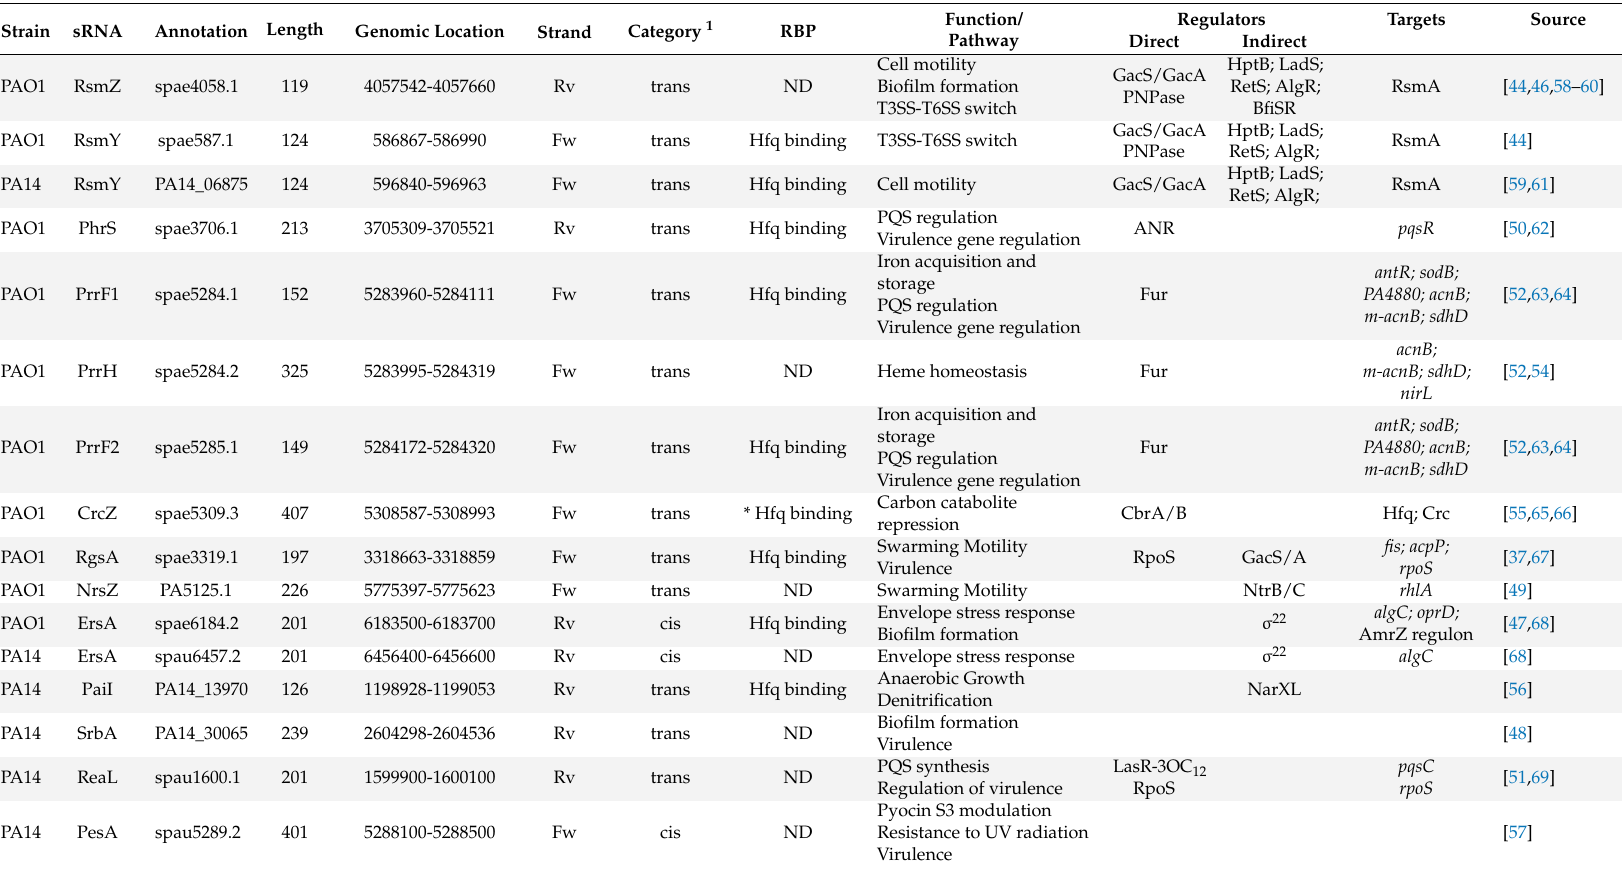
Table 1. Genome location and regulatory interactions of the sRNAs already characterized in P. aeruginosa